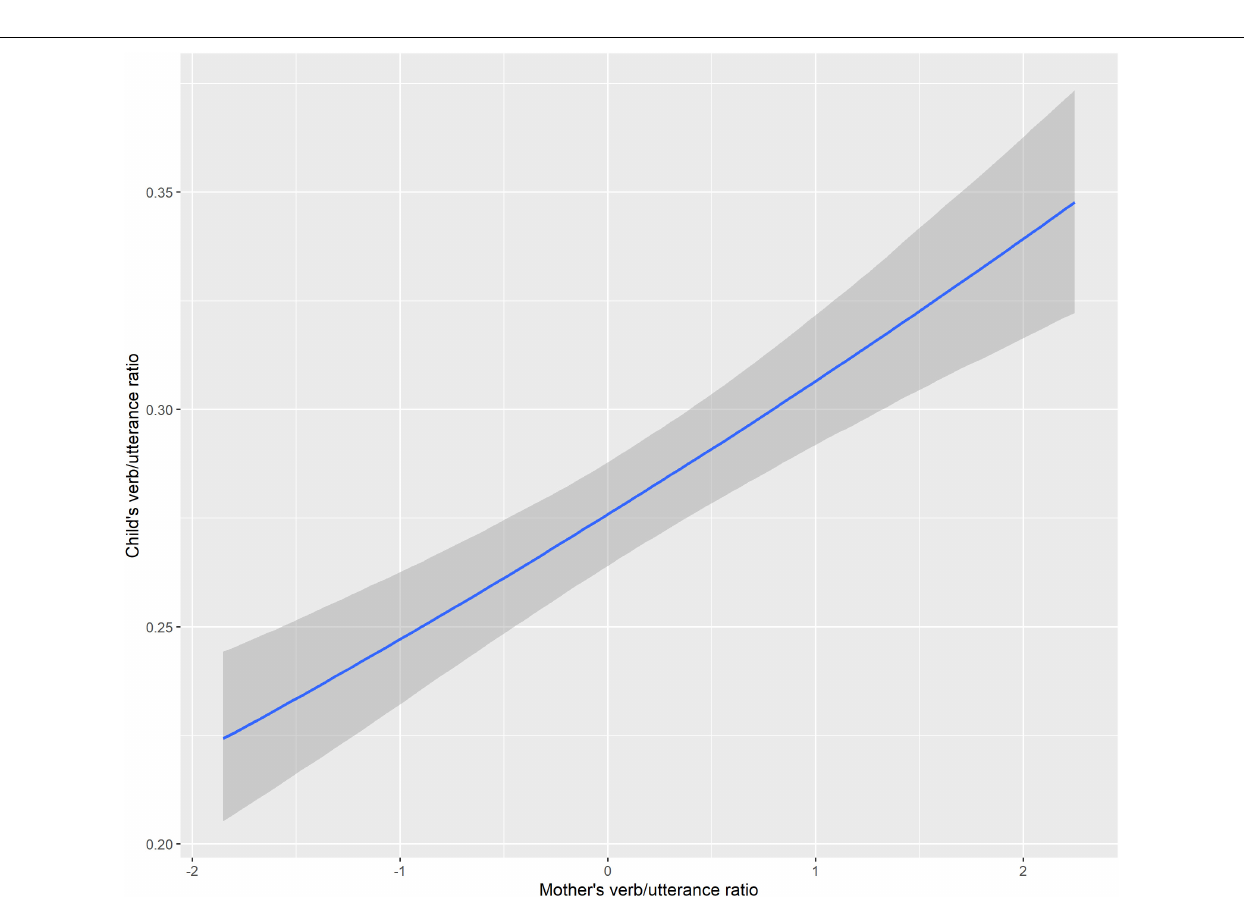
FIGURE 12 | Conditional effects of mother’s verb/utterance ratio on child’s verb/utterance ratio.